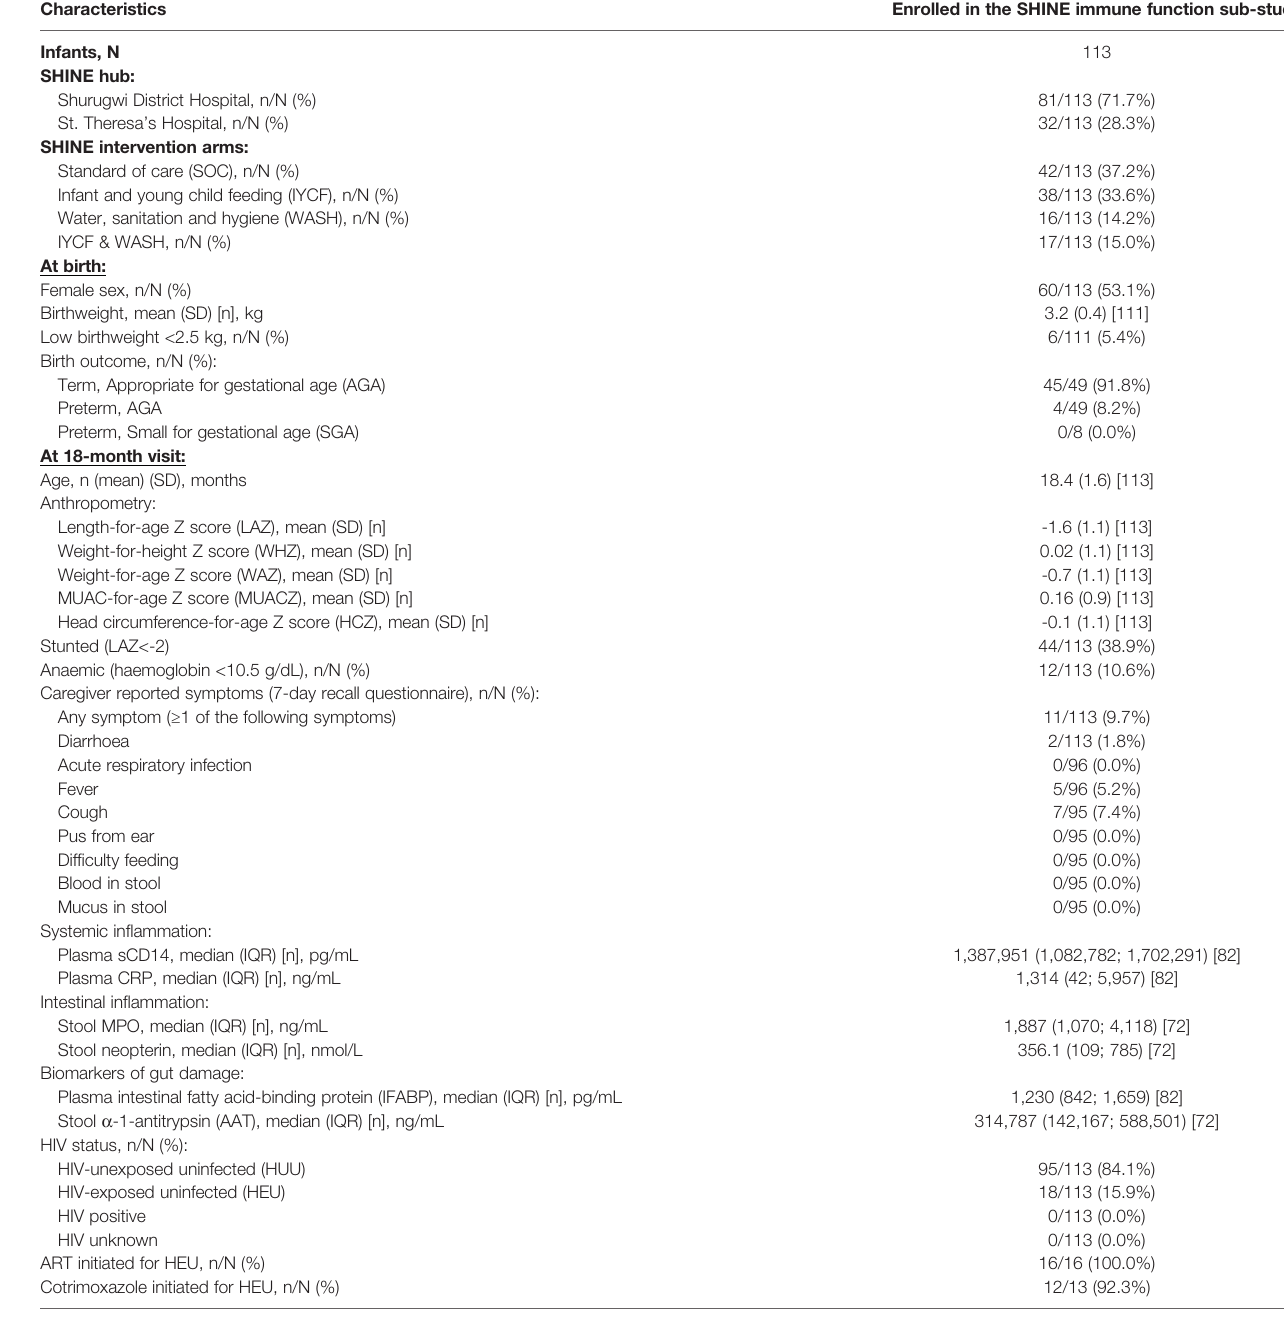
TABLE 1 | Characteristics of infants enrolled in the SHINE immune function sub-study. Characteristics Enrolled in the SHINE immune function sub-study Infants,